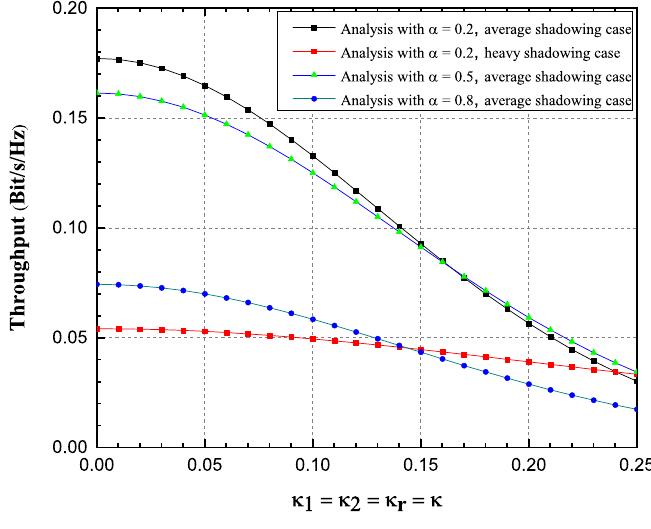
Figure 9. Rician-shadowed fading channels: Achievable throughput versus κ